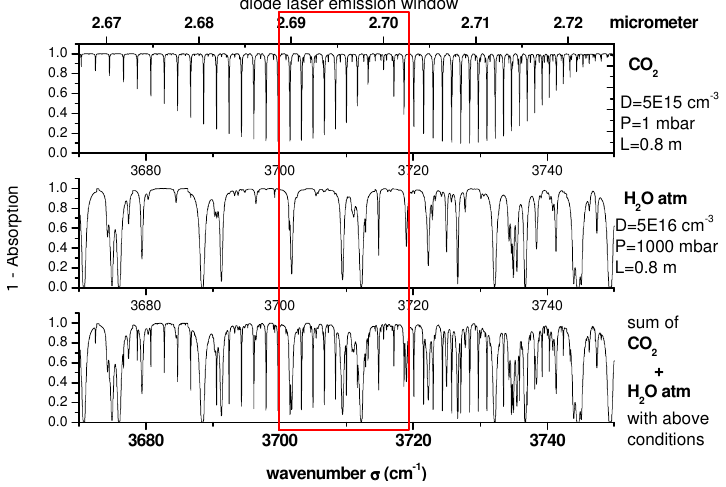
at a pressure of 4 2